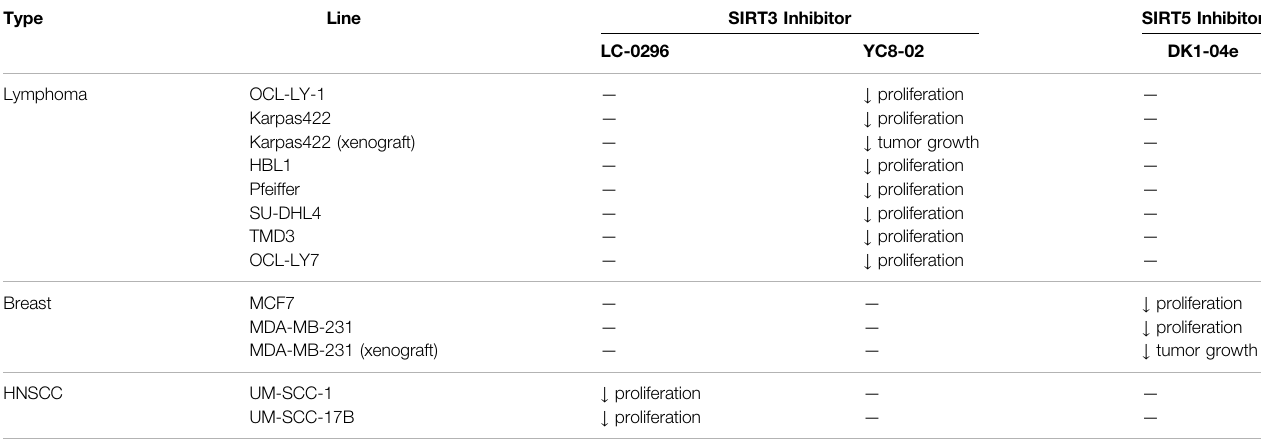
TABLE 5 | Cell lines affected by SIRT3/SIRT5 inhibitors.